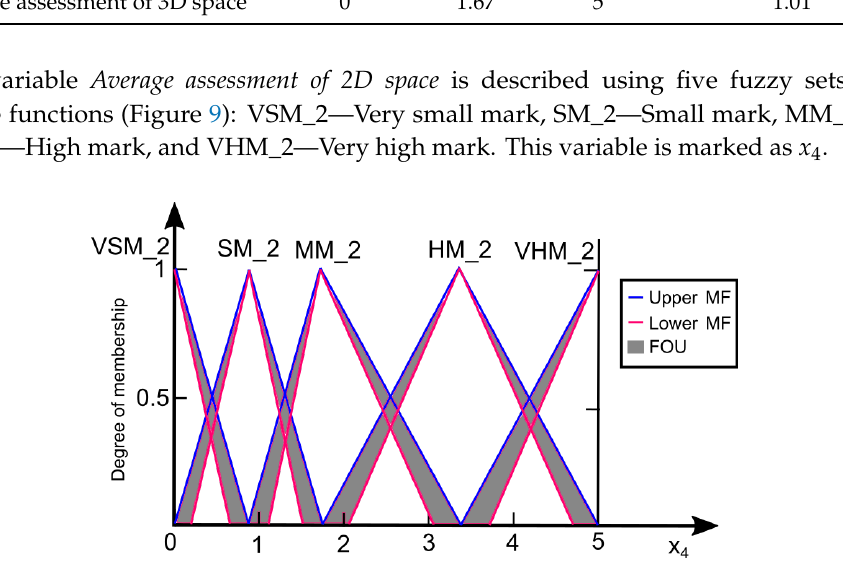
Figure 9. Input variable Average assessment of 2D space. Used notation: MF—membership function; FOU—footprint of uncertainty.